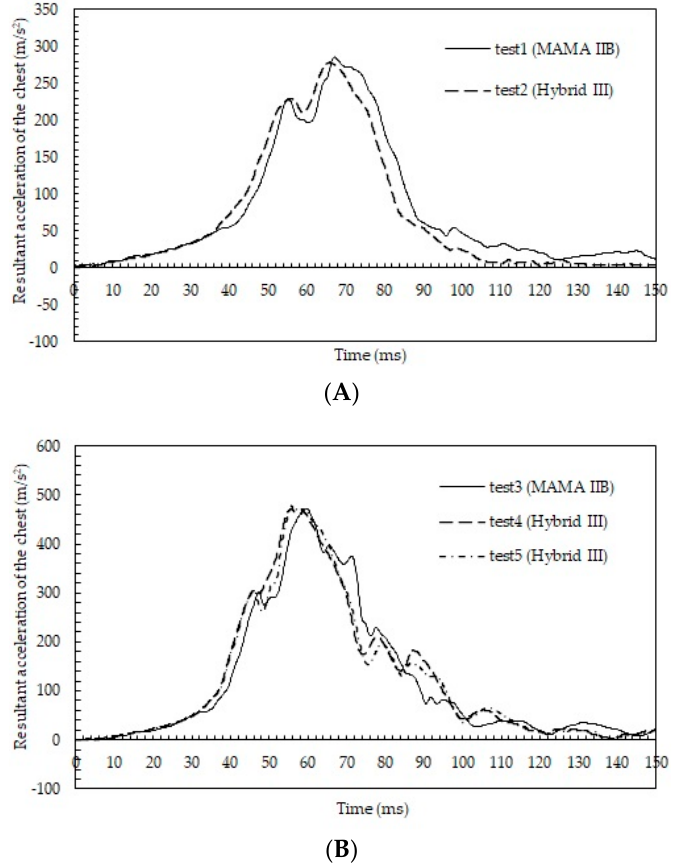
Figure 2. ( A ) Time courses of the resultant accelerations of the chest in tests 1 and 2; ( B ) time courses of the resultant accelerations of the chest in tests